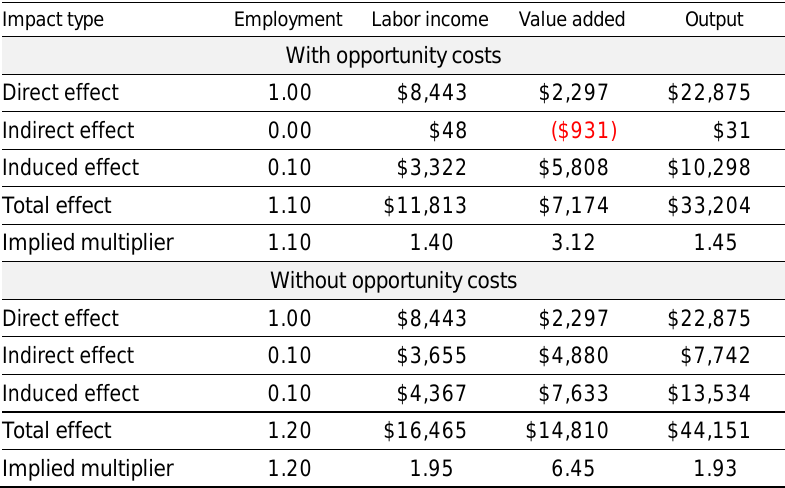
Table 4. Summary of Impact Results for MPLS Study Area, With and Without Opportunity